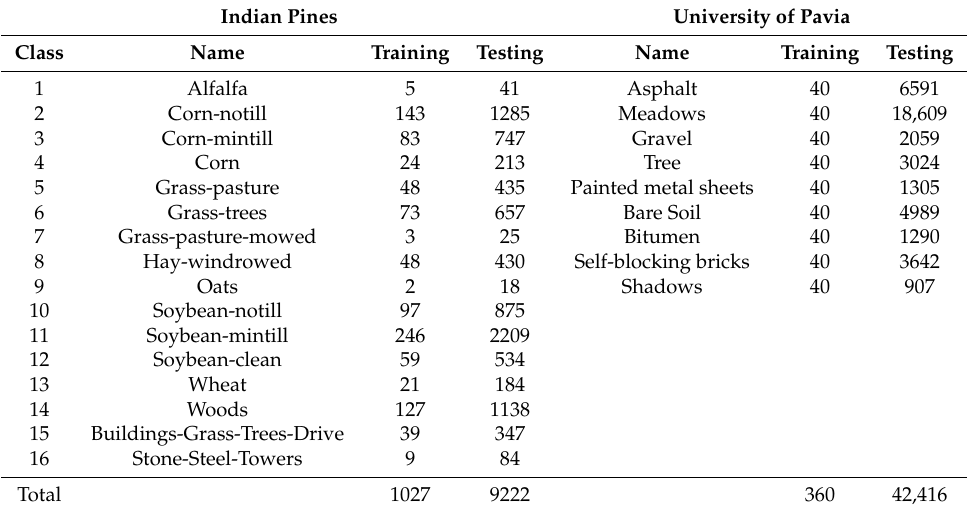
Table 1. Number of training and testing samples for the Indian Pines and University of Pavia datasets.